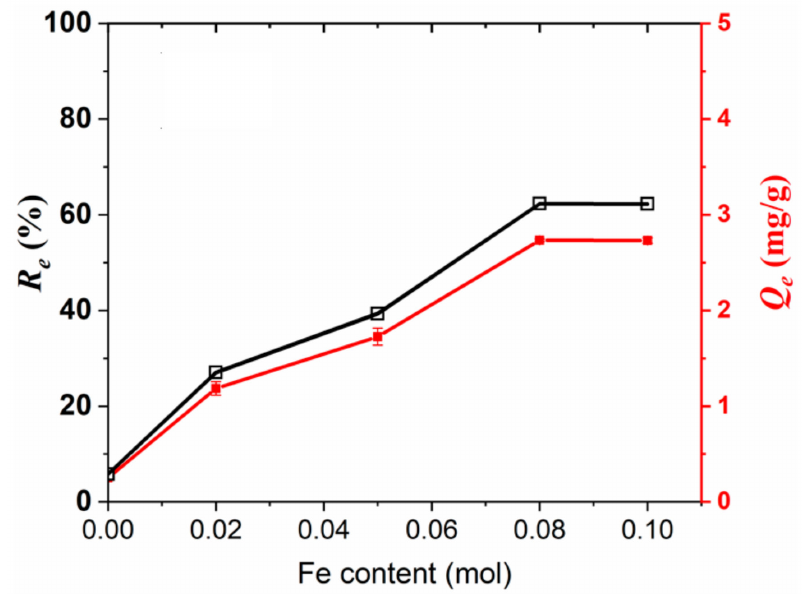
Figure 8. Changes in As(III) adsorption capacities ( Q e ) and removal efficiency ( R e ) with the Fe content.